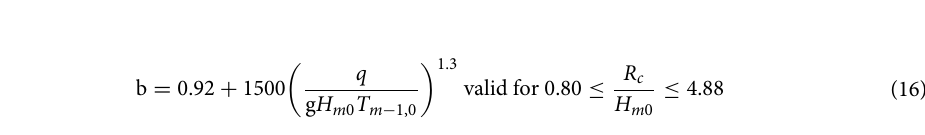
Figure 6. Influence of impulsiveness parameter on Weibull b parameters: (a) impulsive wave conditions and (b) non-impulsive wave